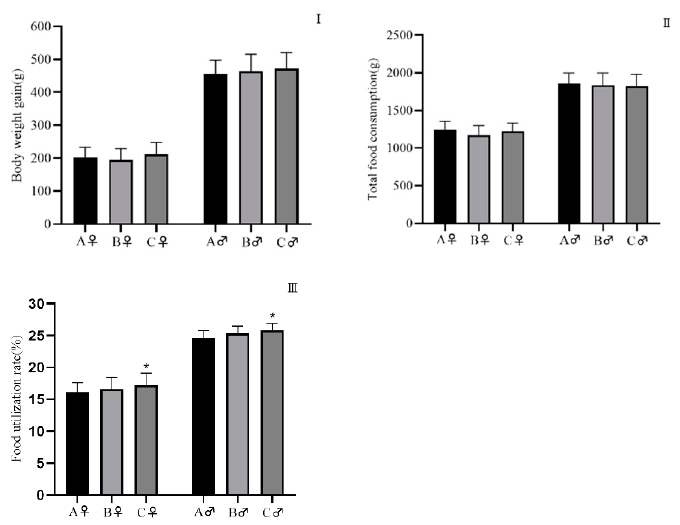
Figure 4. Total body weight gains, total food consumption, and total food utilization for 10 weeks in male and female rats. A: control group; B: HS group; C: HJM group. ( I ): total body weight gain; ( II ): total food consumption; ( III ): total food utilization. Compared with the control group, * P < 0.05.